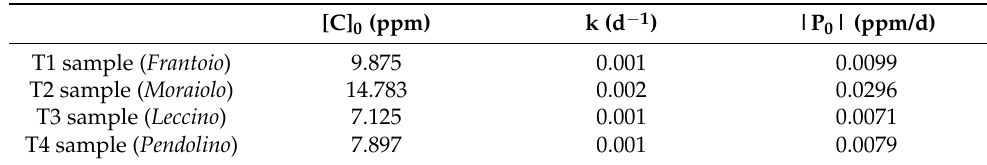
Table 5. Initial concentration, [ C ] 0 (ppm), of lutein in the four monocultivar not-fresh EVOO samples; kinetic constant, k (d − 1 ), absolute value of P 0 , obtained analyzing the trends of concentration of lutein during time. ‘d’ stands for